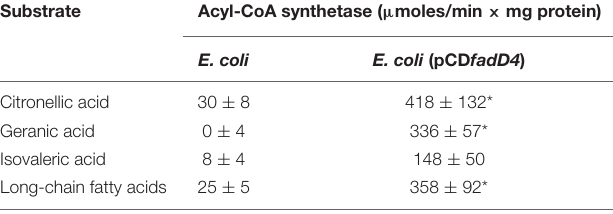
TABLE 3 | Acyl-CoA synthetase activity in cell-free extracts of E. coli expressing the fadD4 gene from P. aeruginosa PAO1.